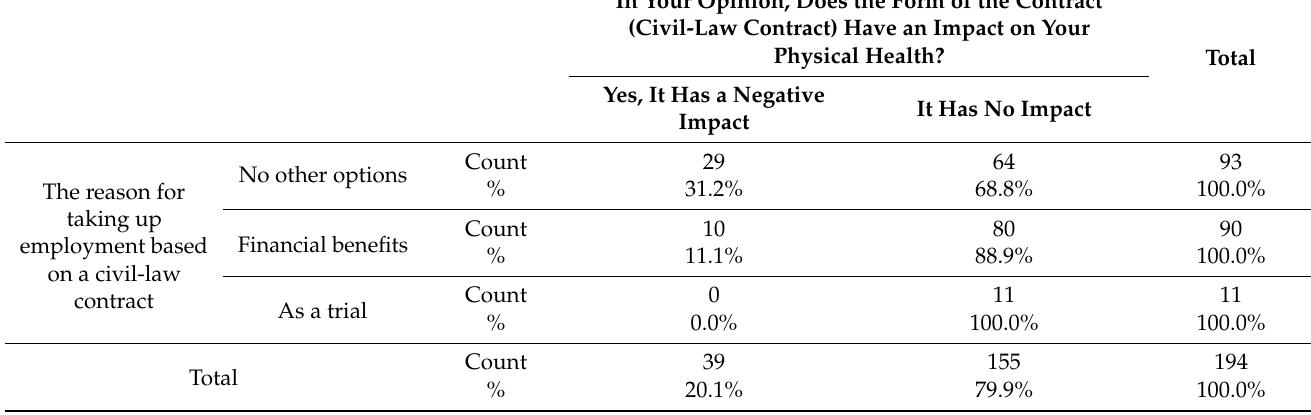
Table 5. The frequency of responses regarding the impact of the form of employment on workers’ physical health based on the reason for taking up